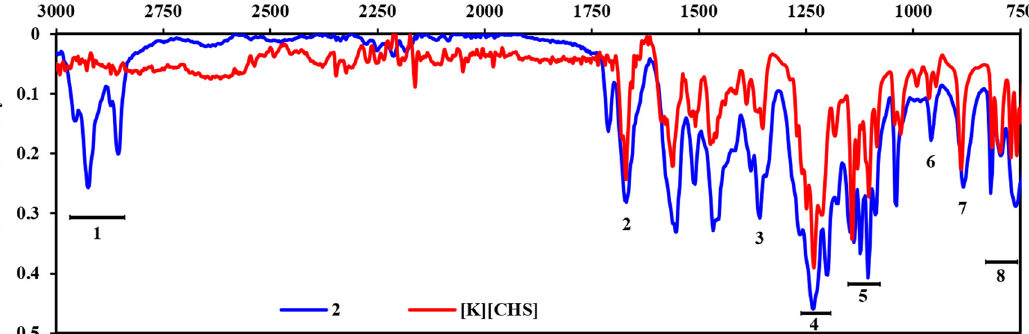
Figure 3: FT - IR spectra of IL comprising a didecyldimethylammonium cation ( 2 ) and potassium salt of chlorsulfuron [ K ][ CHS ]